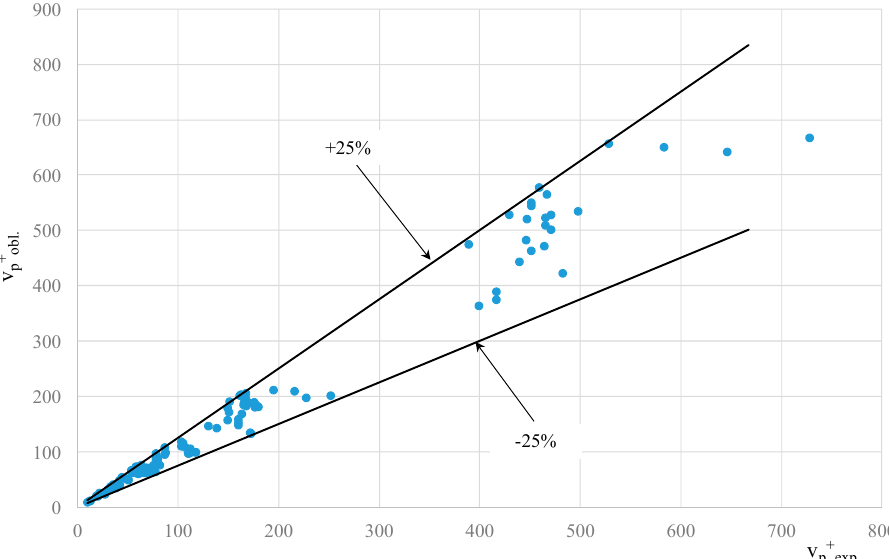
+ v regp . obtained by dimensional analysis on the + v for R1234ze. exp. p